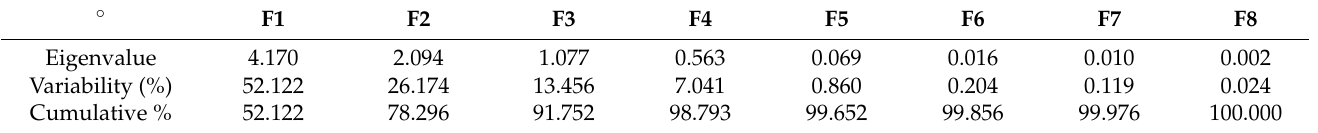
Table 2. Calculated eigenvalues of each variable. Source: Author’s contribution based on data